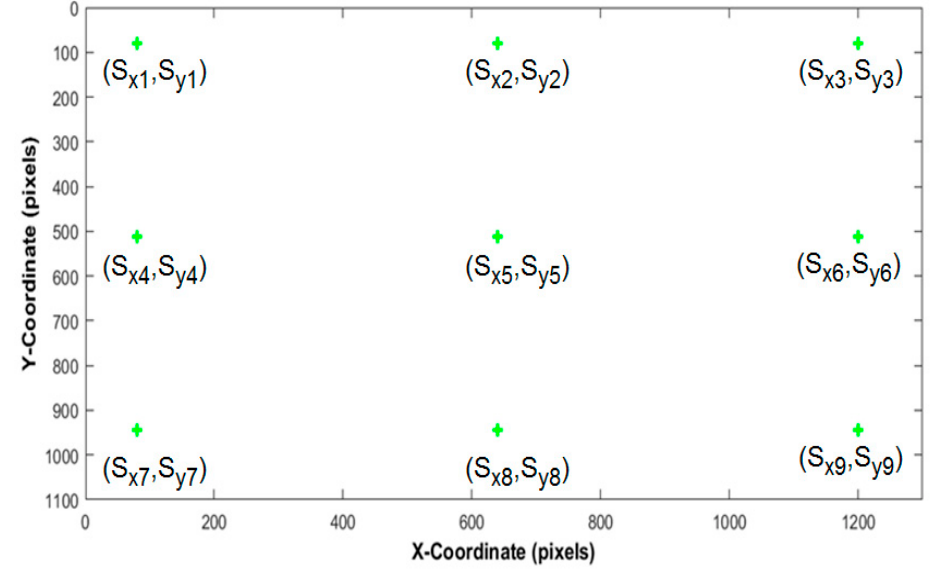
Figure 8. User calibration points of the eye gaze tracker.